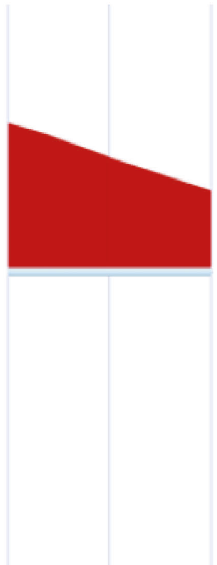
Figure 17: Normal stress distribution at y � − 10.562m after prestressing.